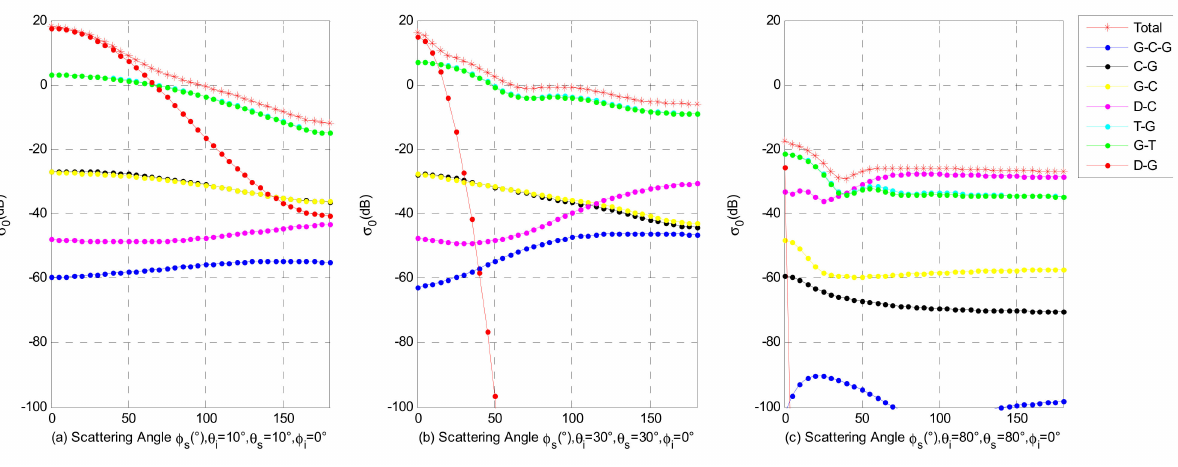
Figure 8. Scattering characteristics at the specular cone for LR polarization. ( a ) θ i = 10 o , θ s = 10 o , ϕ i = 0 o ; ( b ) θ i = 30 o , θ s = 30 o , ϕ i = 0 o ; ( c ) θ i = 80 o , θ s = 80 o , ϕ i = 0 o